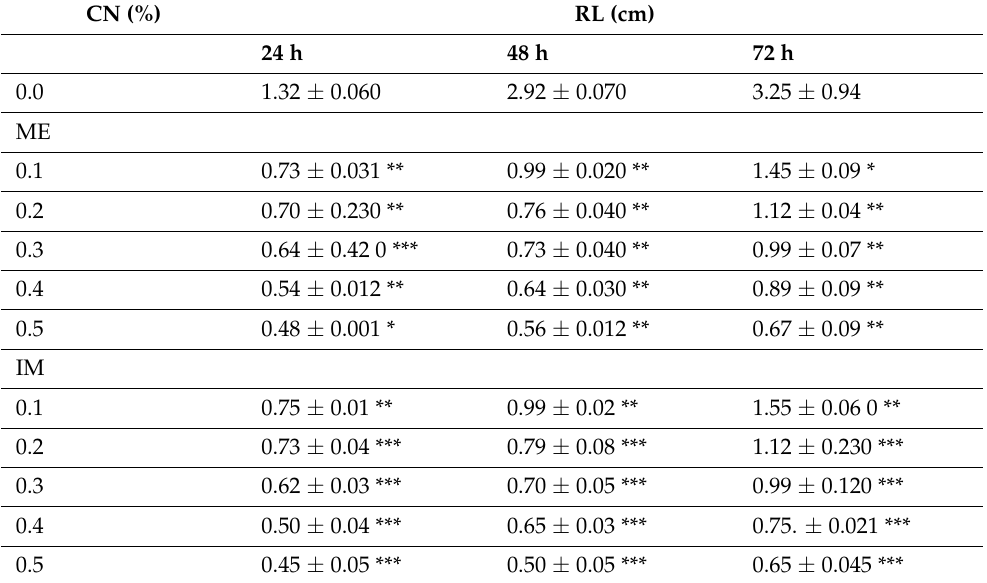
Table 3. Effect of ME and IM on RL of P. sativum at different concentrations for 6